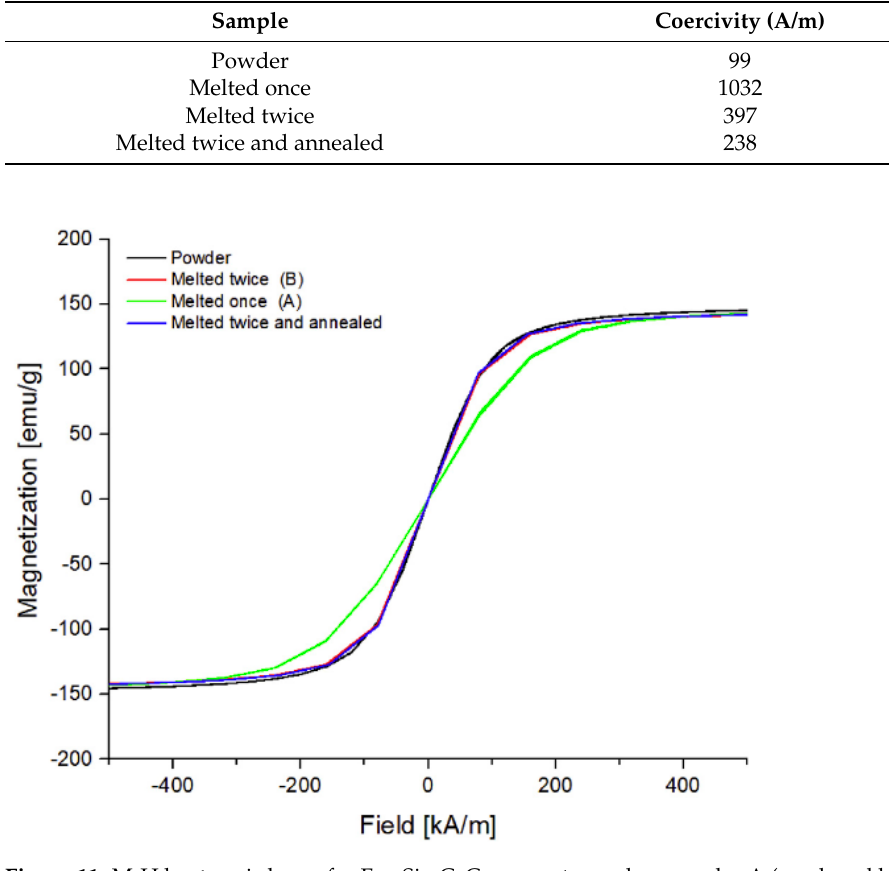
Figure 11. M-H hysteresis loops for Fe 71 Si 10 C 6 Cr 2 parent powder, samples A (produced by melting every powder layer only once) and B (fabricated by melting each powder layer twice), and sample